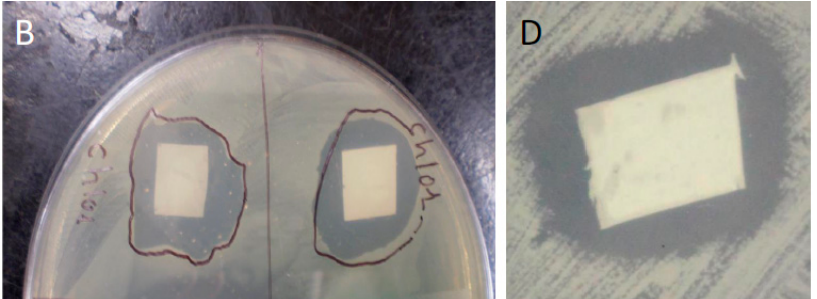
Figure 8. Doped HNT/PCL mats applied to confluent bacterial cultures. 5% HNT/PCL nanocomposites loaded with amoxicillin ( A ) and chlorhexidine ( B ) and applied to confluent cultures of E. coli. Black lines outline extent of anti-bacterial growth zone; ( C ) Zone of inhibition of S. aureus growth around empty halloysite-PCL scaffolds showing no antibacterial effect; ( D ) PCL mats with HNTs doped with Brilliant Green. ( A – D ) were photographed one week after application of doped mats.